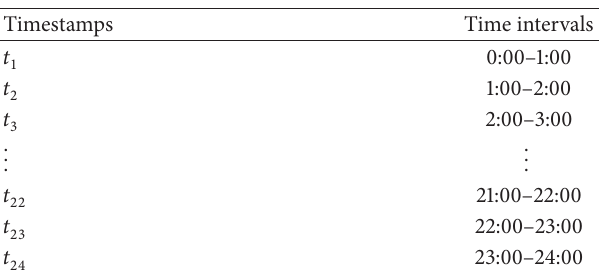
Table 2: Timestamp table.